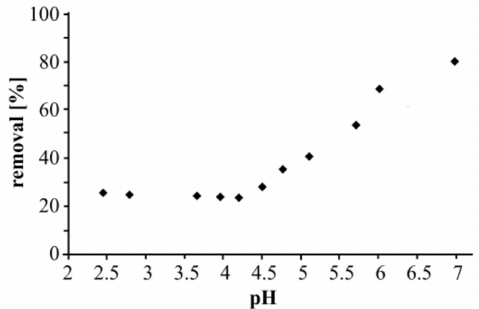
Figure 1. Influence of pH on zinc adsorption on